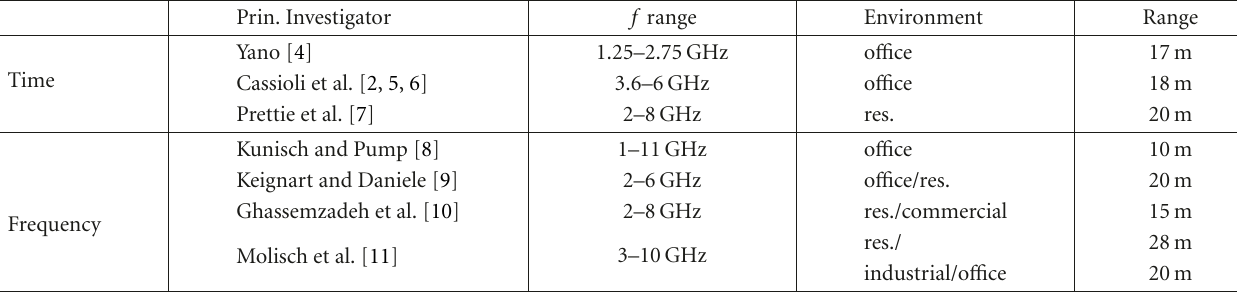
Table 1: Overview of reported indoor UWB